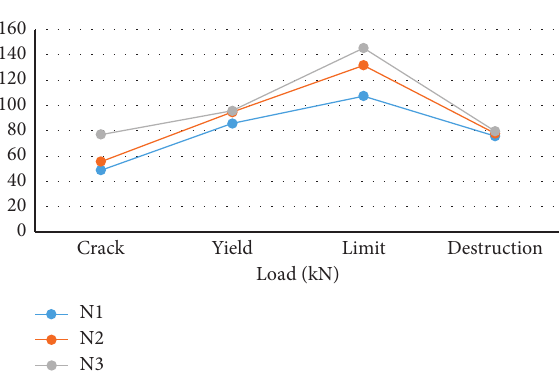
Figure 2: Bearing capacity of frame